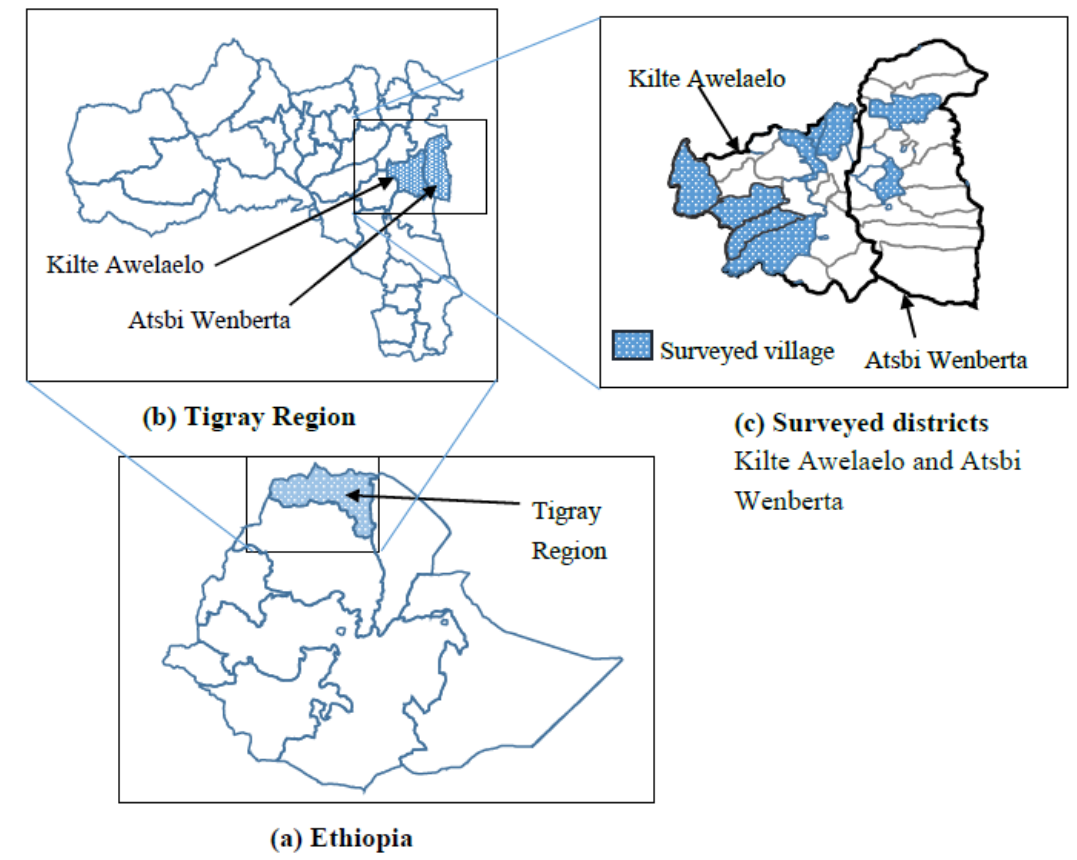
Figure 2. Survey site. (a) Ethiopia; (b) Tigray Region; (c) Surveyed districts.